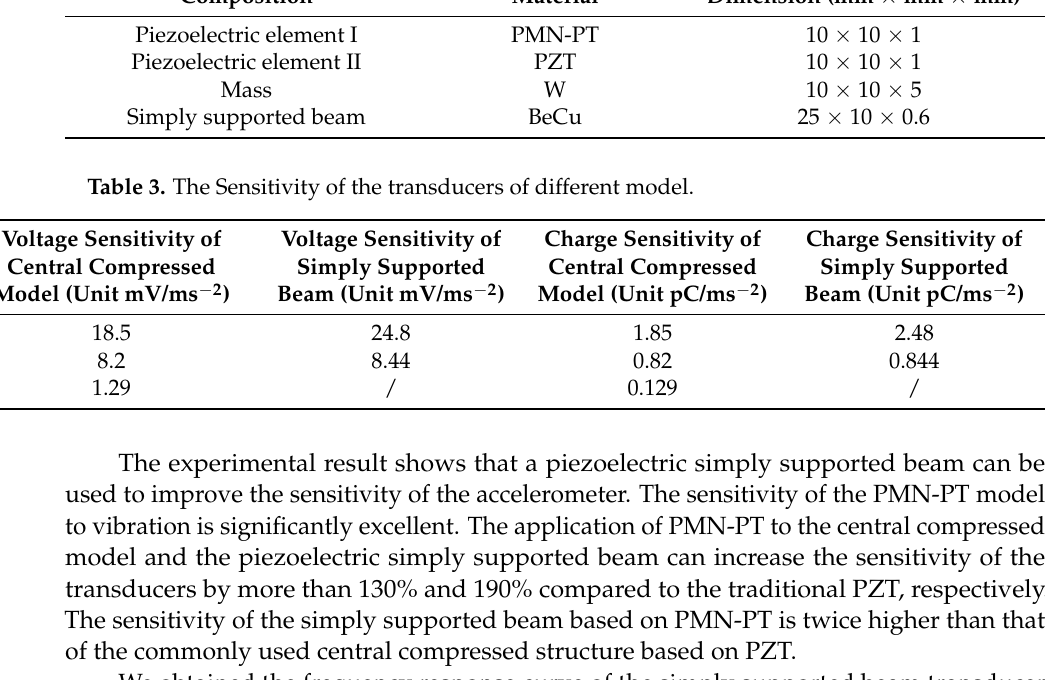
Table 3. The Sensitivity of the transducers of different model.